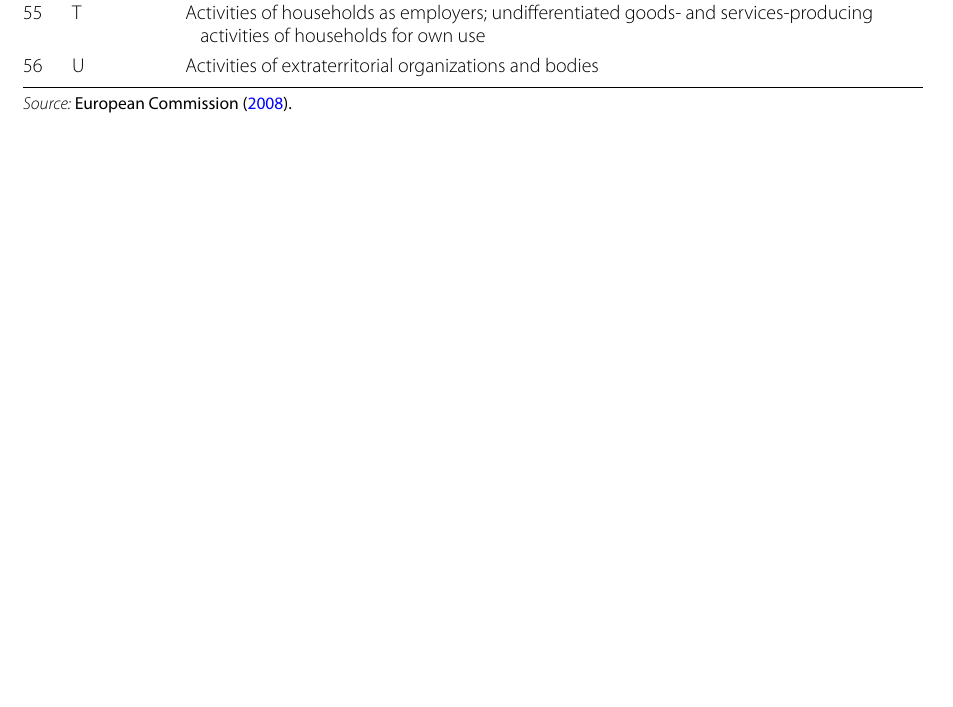
Source: European Commission